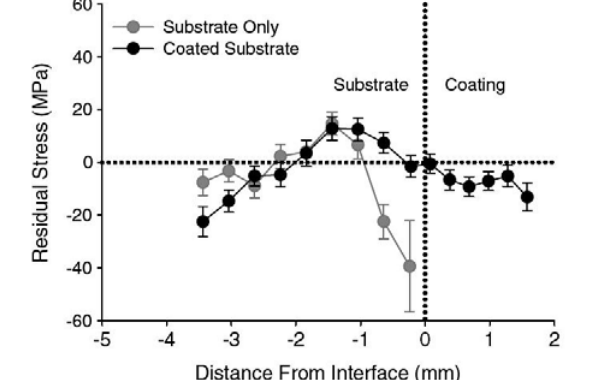
Figure 13: Residual stress measurement of CS Al coating